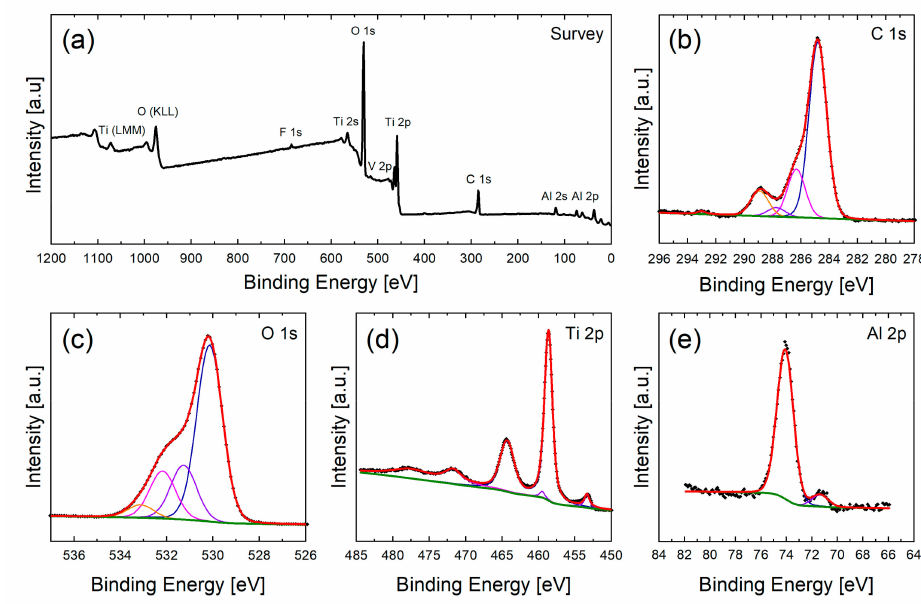
Figure 4. XP spectra of the structured sample without cleaning after 1d storage in air. This sample serves as a reference towards cleaned samples. In the survey spectra ( a ) the main components Ti, O, Al, C as well as small F contamination can be identified. The detailed high-resolution scans of C 1s ( b ), O 1s ( c ), Ti 2p ( d ) and Al 2p ( e ) are shown below. The O 1s region can be described with four peaks (see Figures 3c and 4c). Signals at about 530.2 eV and 531.2 eV are attributed to lattice oxygen of TiO 2 [50] and Al 2 O 3 as well as carbonyl groups (C = O) [30,51], respectively. A binding energy of about 532.1 eV is characteristic for